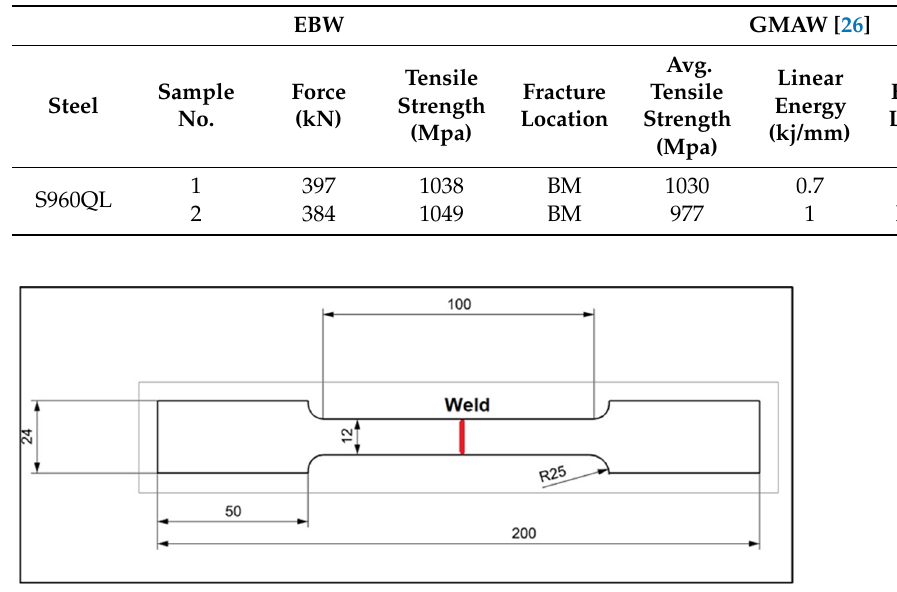
Table 8. Hardness test (HV10) results of EB-welded S960QL joint.